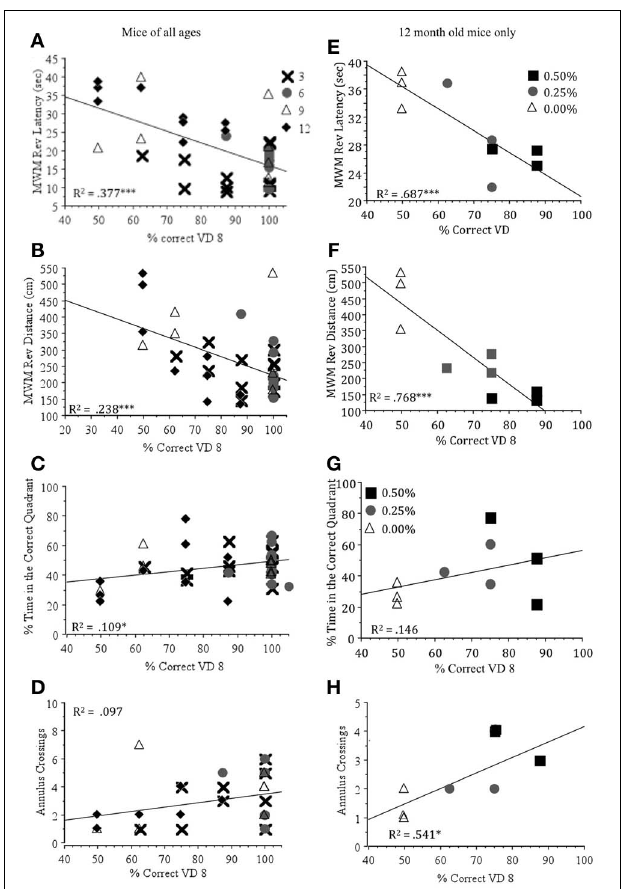
FIGURE 5 | Regression plots showing the correlation between the percent correct on Day 8 of the visual detection task (% Correct VD 8) and latency (sec) (A,E), swim distance (cm) (B,F), the percentage of time spent in the correct quadrant (C,G) and annulus crossings (D,H) in the probe trial in Morris water maze for mice at all ages ( N = 38) and at 12 months of age ( N = 9). ∗ p < 0 . 05, ∗∗∗ p < 0 . 01.